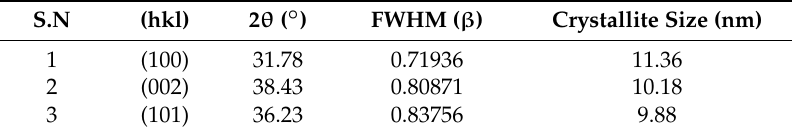
Table 1. The crystallite size of the hydrothermally synthesized ZnO nanoballs.